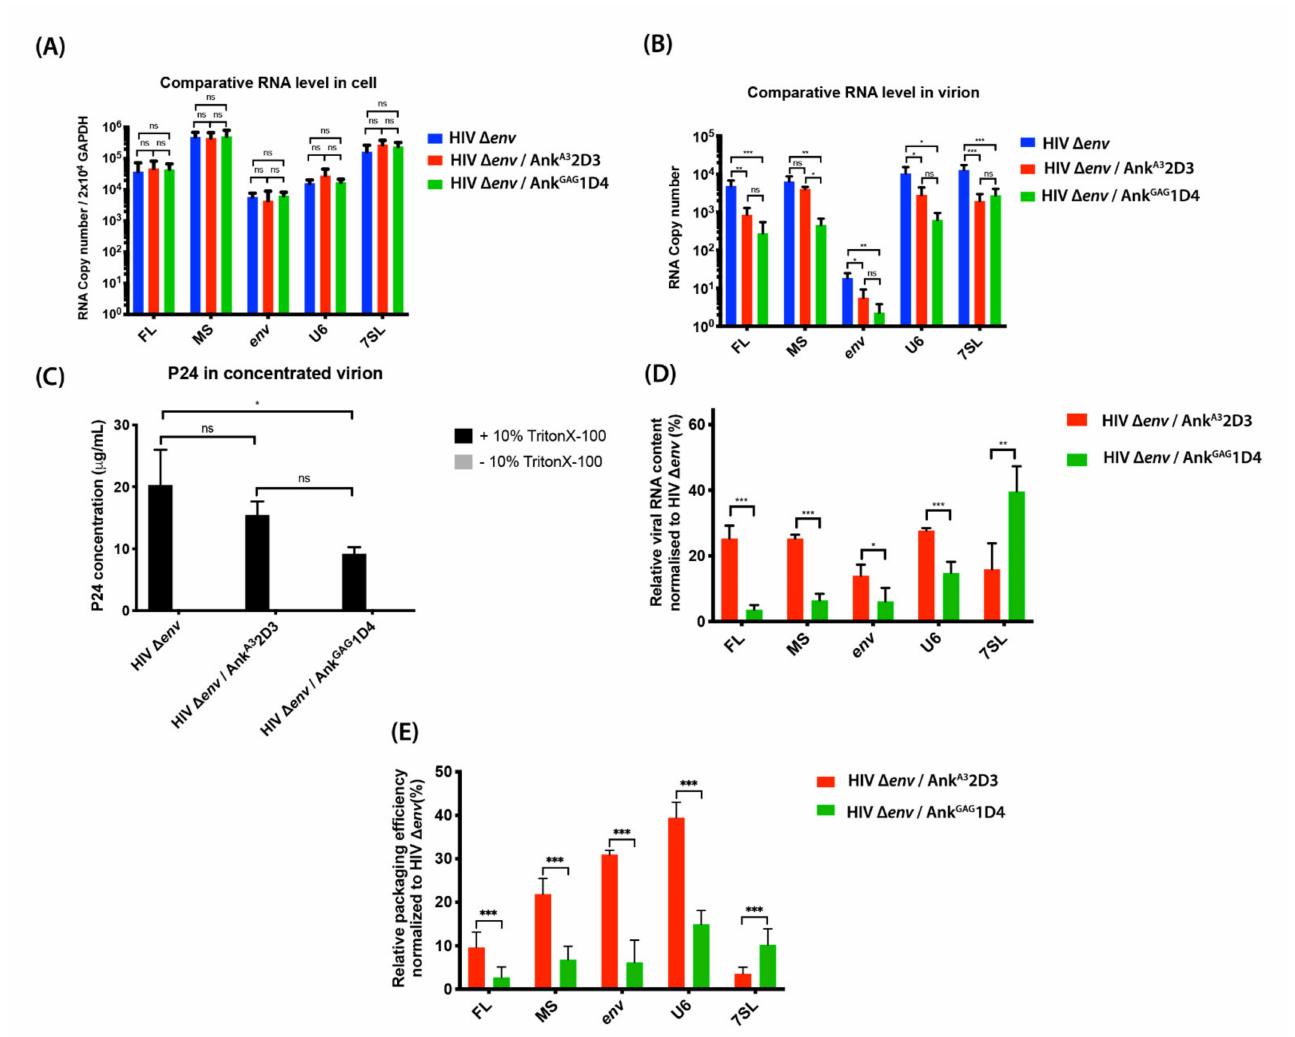
Figure 4. RNAs levels and packaging efficiency. At 24 h post-transfection, ( A ) Total cellular RNA was extracted and purified. The amounts of viral RNA (FL, MS, and env) and cellular RNA (U6 and 7SL) within cells were determined by RT-qPCR. The copy numbers were normalised to that of cellular GAPDH mRNA. ( B ) Total RNA in virions was concentrated, and the intravirion levels of viral RNA (FL, MS, and env) and cellular RNA (U6 and 7SL) were determined by qPCR. ( C ) The p24 concentrations in virion-containing supernatants were determined in the presence or absence of 10% TritonX-100, using a p24-ELISA. ( D ) The viral RNA contents were calculated by the percentage of total RNA level in virions at 100 ng of p24 (RNA copies/100 ng p24 × 100) normalised to HIV ∆ env alone. ( E ) The packaging efficiency was calculated by the total viral RNA in virions relative to total cellular RNA and normalised to HIV ∆ env alone. Data represent the mean ± SD from the triplicate independent assay. *** p < 0.001; ** p < 0.01; * p < 0.1; ns, not significant using one-way